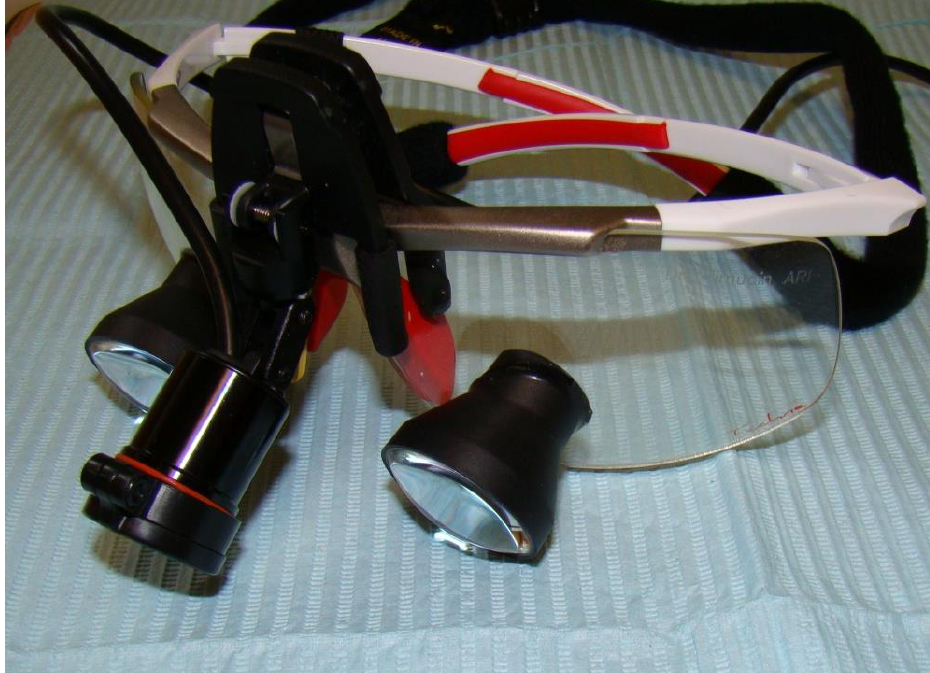
Figure 1. 2.5 × magnification dental loupe with LED